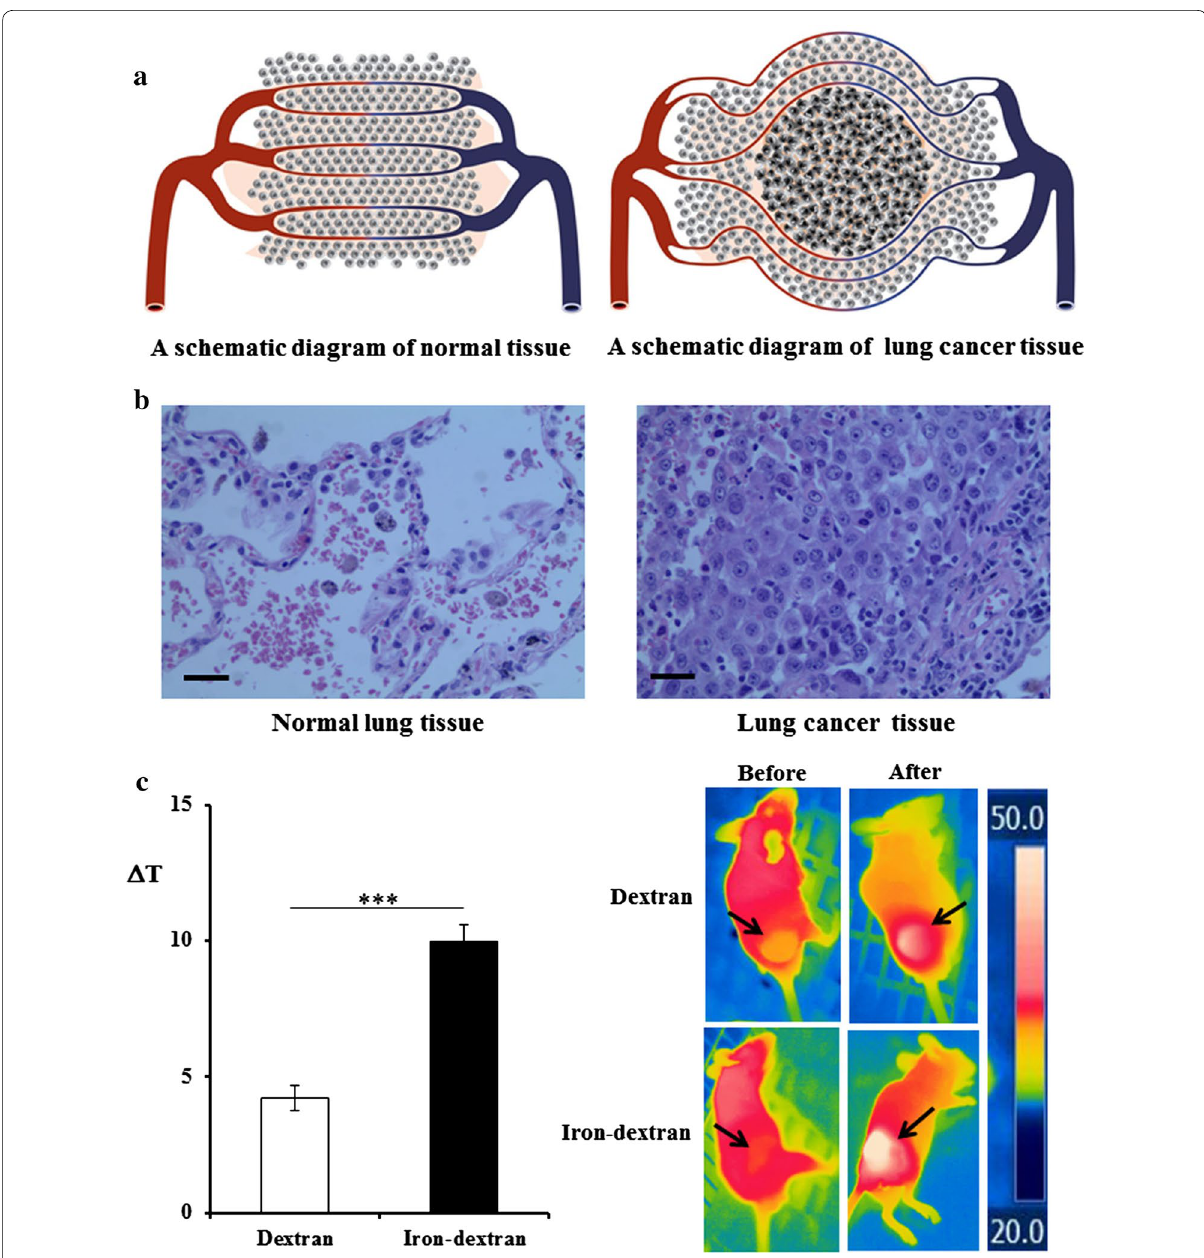
Fig. 2 Iron‑dextran boosted temperature elevation in cancer‑bearing mice upon 13.56 MHz RF hyperthermia. a Schematic drawing of vasculature in cancer and normal tissues. The excessive heat in the cancer tissues is difficult to be diffused into other parts of body via blood flow, resulting cancer tissues more vulnerable to hyperthermic oncotherapy. b H&E staining of cancer tissue showed the abnormal chaotic vasculature with active angiogenesis and slowed blood flow. Scale bar, 100 µm. c The temperature elevation in tumor tissue was dramatically boosted by local hyperthermia using 13.56 MHz RF wave with iron‑dextran but not with dextran. Data represent the mean significance as analyzed by a paired Student’s t‑test; *** p < 0.001 with the